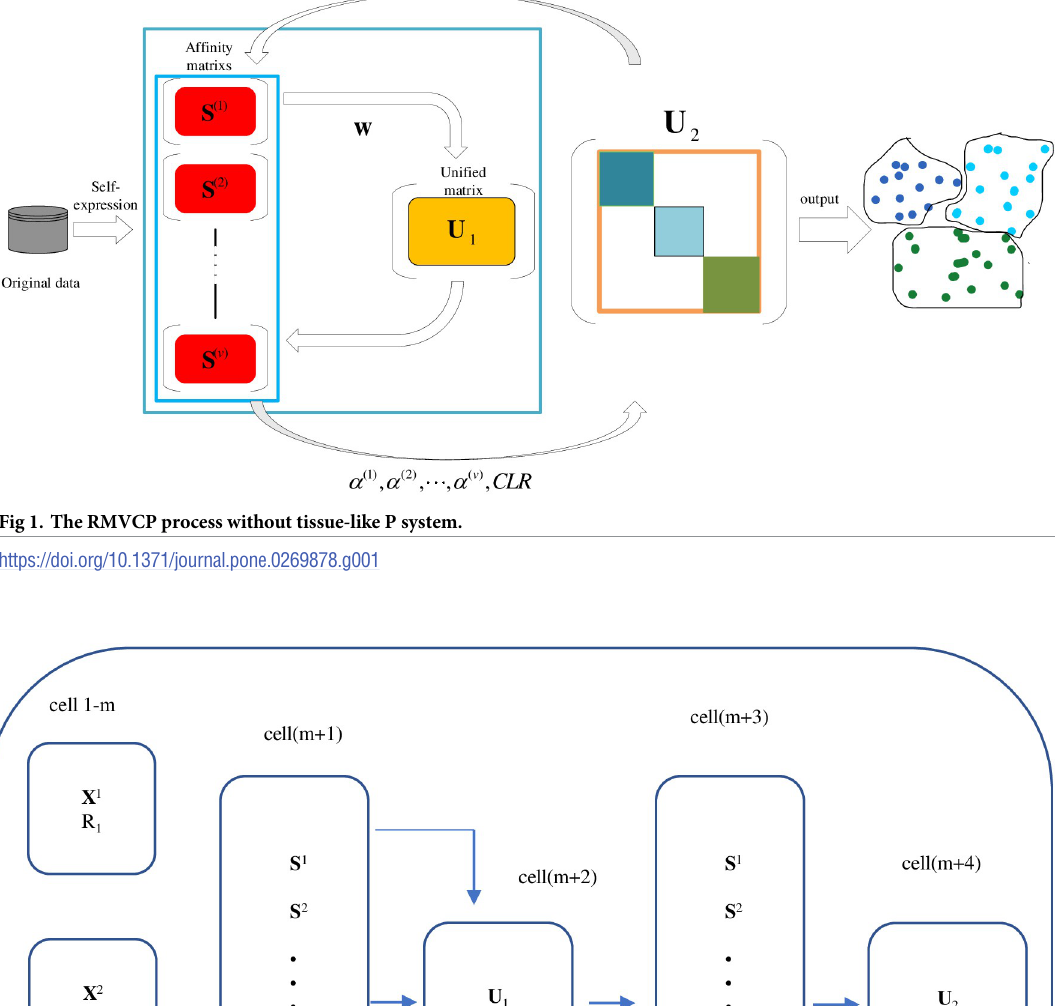
PLOS ONE | https://doi.org/10.1371/journal.pone.0269878 February 10,